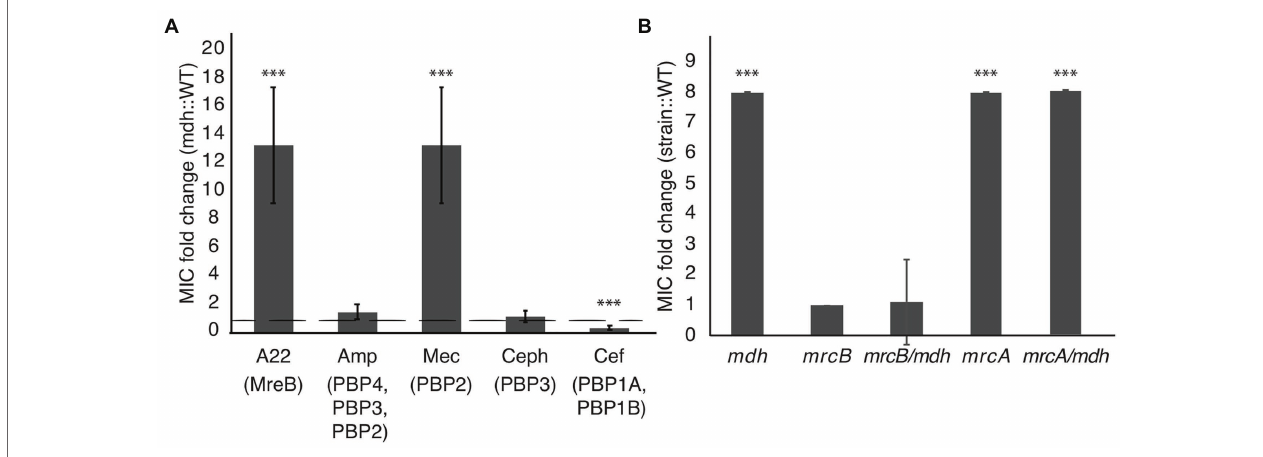
FIGURE 5 | Malate dehydrogenase mutation provides increased MIC specifically of A22 and mecillinam. (A) MIC assays were performed for the indicated antibiotics. Amp, ampicillin; Mec, mecillinam; Ceph, cephalexin; and Cef, cefsulodin. A fold change of 1 (dotted line) indicates no change. (B) A22 MIC comparing WT cells with the indicated strains. *** p < 0.001 comparing each strain to